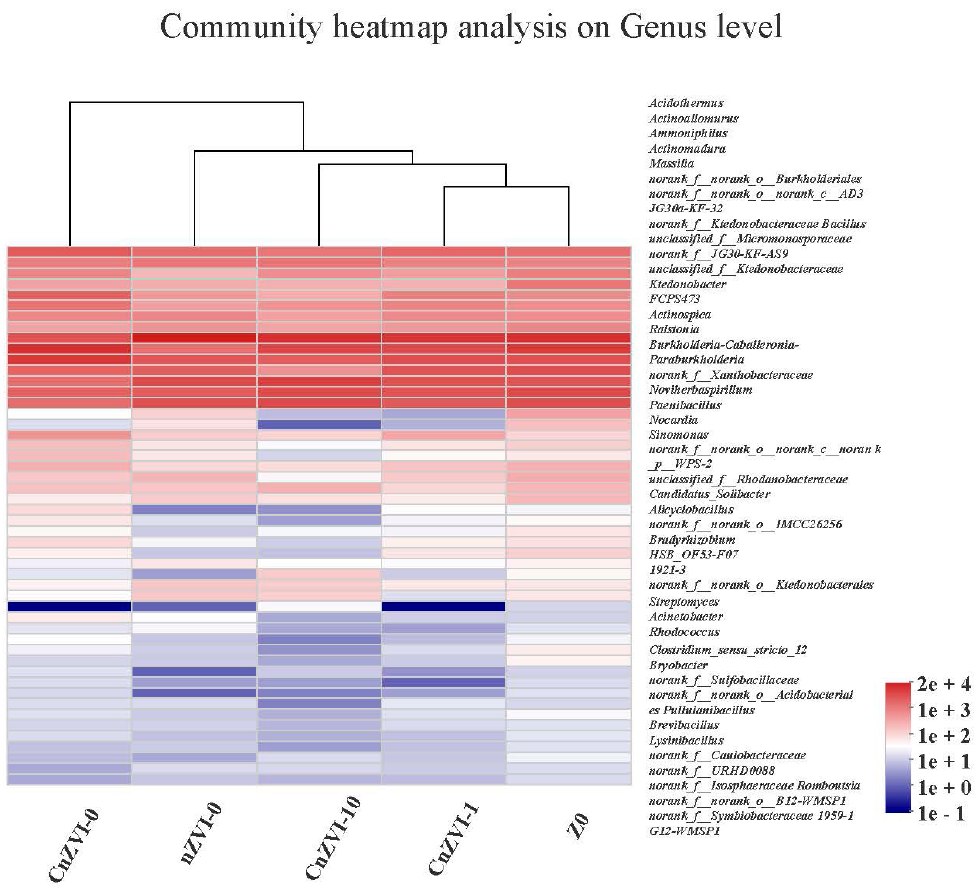
Figure 8. Hierarchical cluster analysis of microbial communities among the 5 samples. Different samples were clustered based on the complete linkage method. The color intensity of scale indicates the relative abundance of each genus.